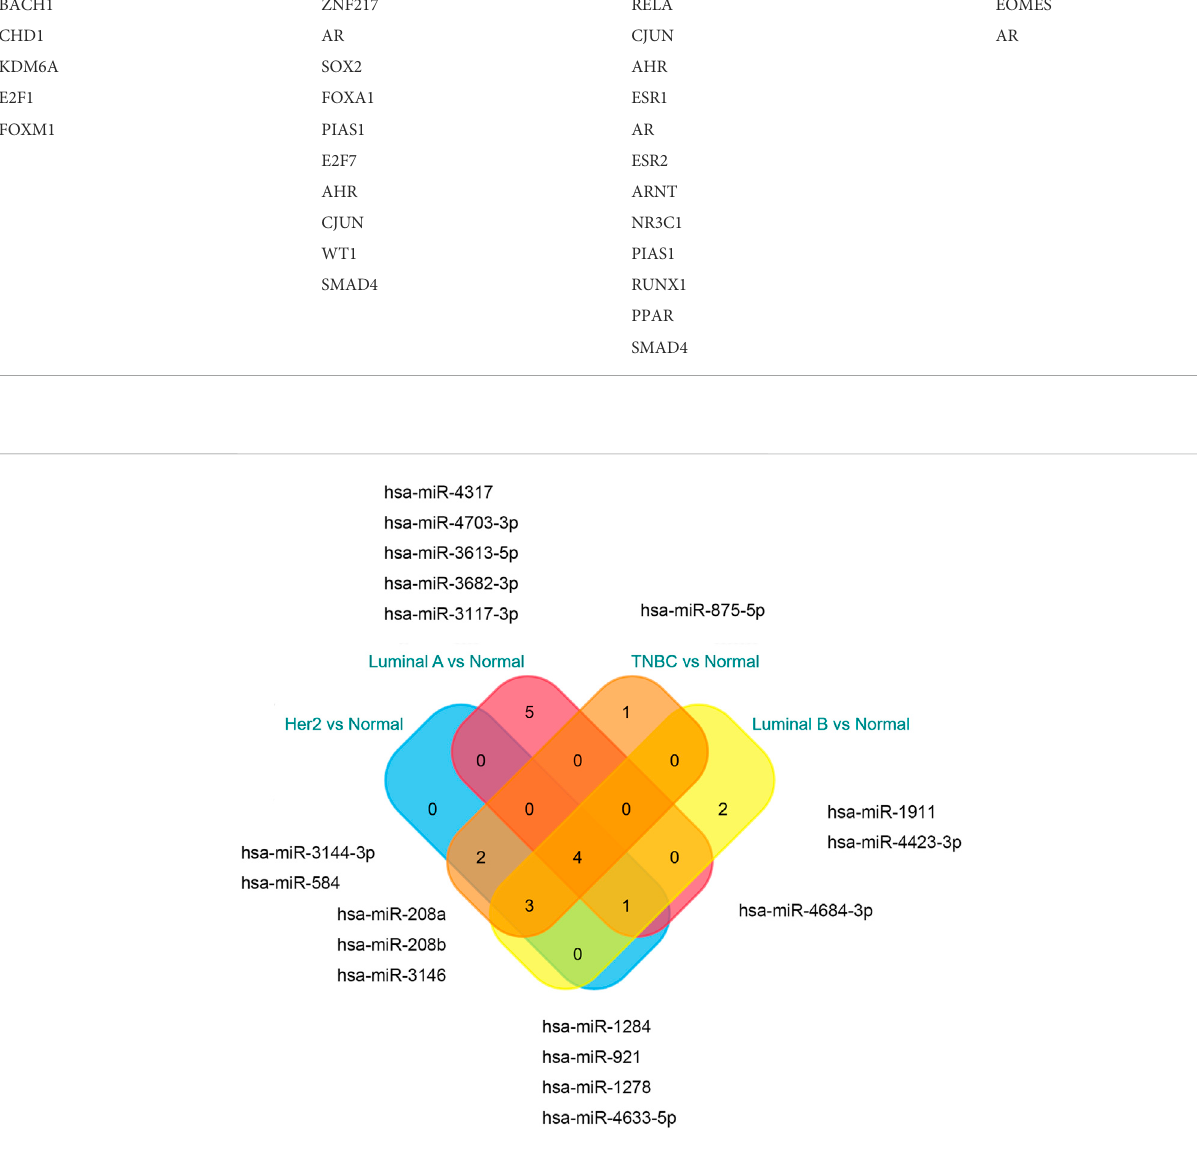
FIGURE 10 miRNA enrichment analysis